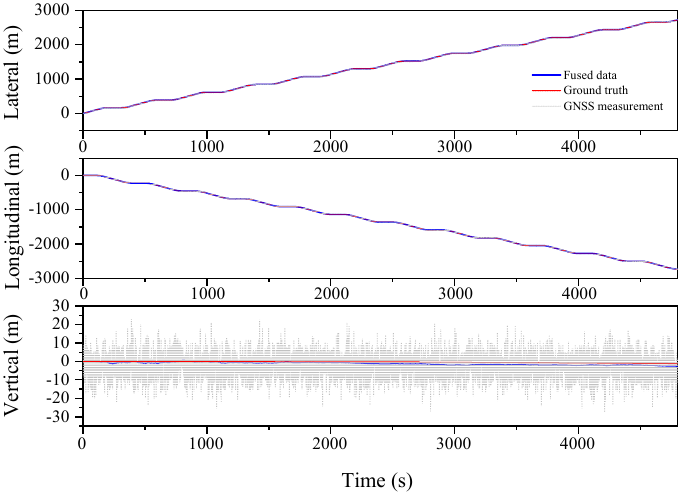
Figure 9. Lateral, Longitudinal and Vertical positions of ESKF − RTS (Serpentine 1).